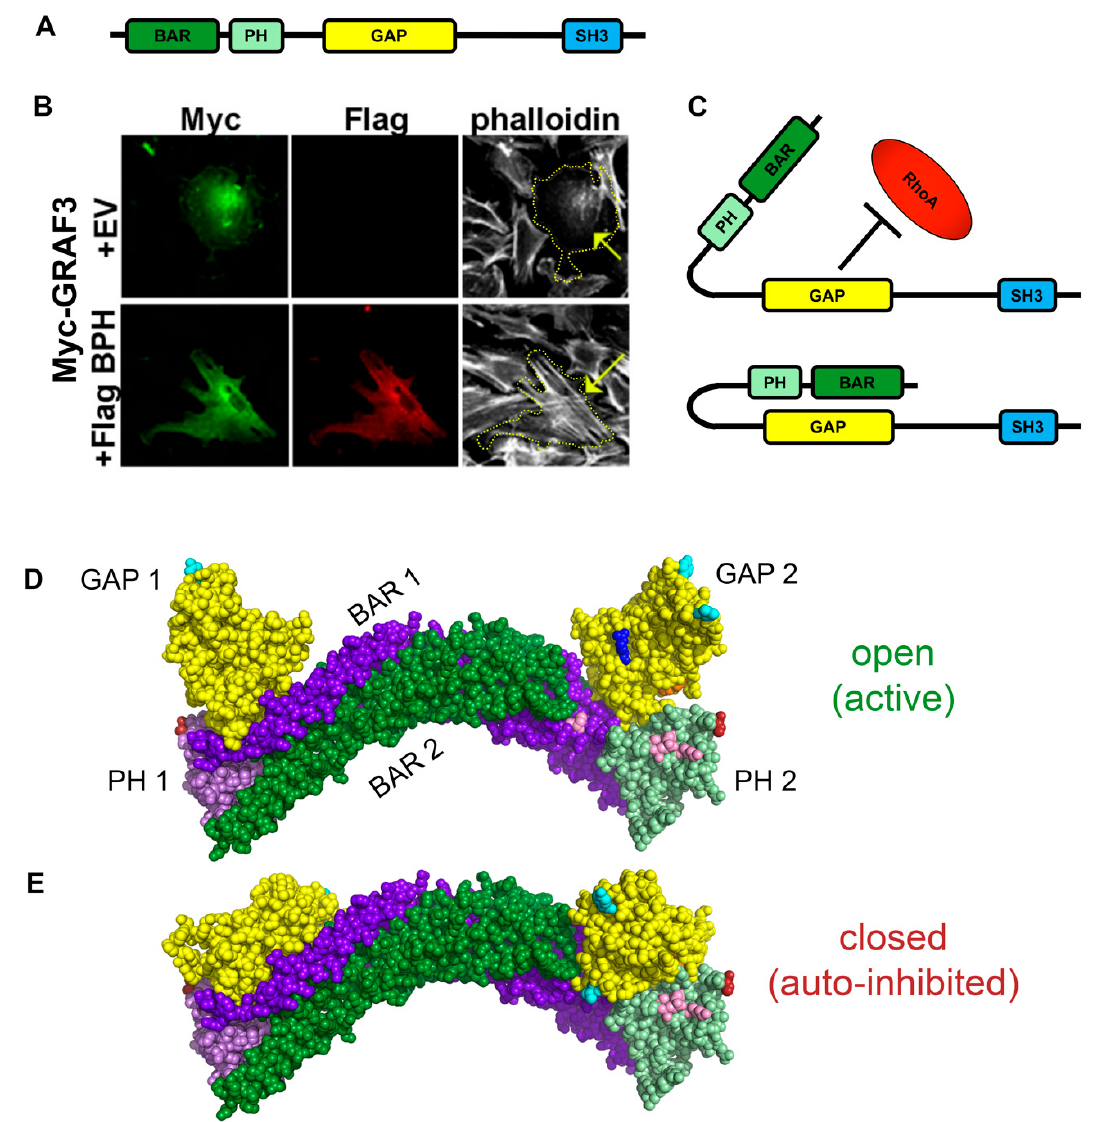
Figure 2. BAR-PH mediated autoinhibition of GRAF3. ( A ) Schematic of GRAF3 monomer domain structure. ( B ) Immunofluorescent staining of RaAoSMCs transfected with Myc-GRAF3 alone or Myc-GRAF3 co-expressed with Flag-BAR-PH (BPH) domain. Yellow arrow and dotted-outline indicate phalloidin-stained cell of interest that is positive for Myc- (green) and / or Flag- (red) staining. Data are representative of over 50 cells / condition from 3 separate experiments (58 / 59 GRAF3 expressing cells and 5 / 72 cells co-expressing GRAF3 and BAR-PH exhibited reduced stress fibers). ( C ) Schematic of GRAF3 in open (active) or auto-inhibited (inactive) conformations. Three-dimensional structures of the GRAF3 BAR-PH-GAP dimer were created using Pymol and the solved, similar structures of Appl1 (BAR-PH) and GRAF1 (GAP). ClusPro docking simulations predicted 2 conformations for GRAF3, ( D ) open and active or ( E ) closed and auto-inhibited. Color scheme follows: BAR 1 (dark purple), PH 1 (light purple), BAR 2 (dark green), PH 2 (light green), GAP 1 and 2 (yellow), arginine fingers (active site) (dark blue), RhoA docking sites (pink), C-terminus of PH domain (red), N-terminus of GAP domain (orange); residues in teal aids in visualizing rotation.